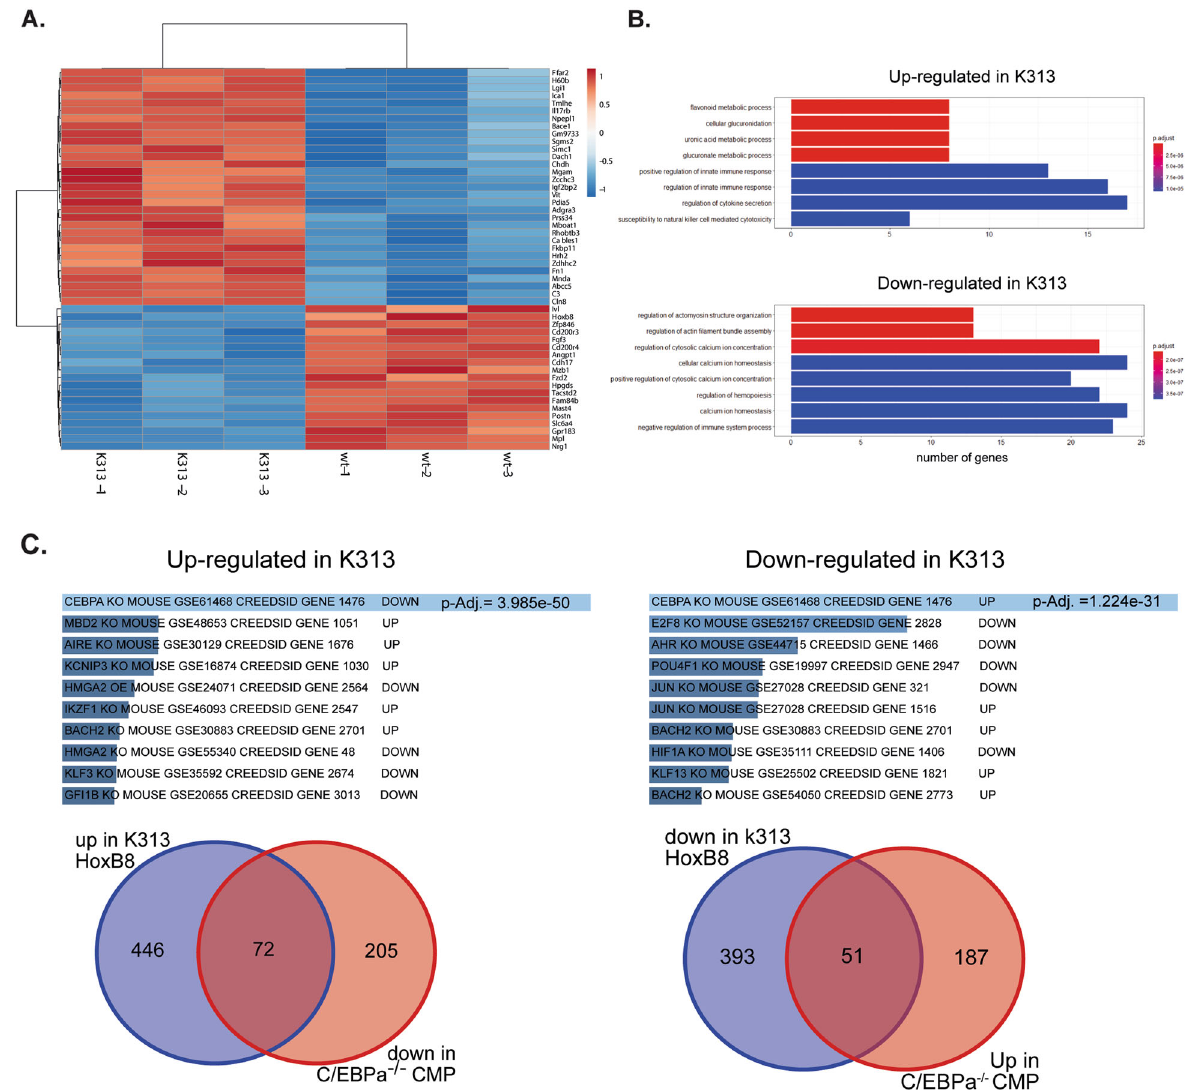
Fig. 3 Differentiating HoxB8 neutrophil progenitors show altered gene expression with C/EBP α -K313 vs. C/EBP α -wt expression. A HoxB8 progenitors were differentiated for 1 day before RNA was extracted and assayed for gene expression using an affymterix gene chip. Heatmap showing the relative expression of the 50 most signi fi cantly differentially expressed genes (DEGs) from three samples of wild type and C/EBPa- K313-expressing cells. B Bar chart showing the most signi fi cant terms in the GO:BP analyses for upregulated and downregulated genes in K313 mutant C/EBPa expressing cells. The x axis refers to the number of enriched genes in the corresponding function. C Results from ENRICHR suite analysis for transcription factor perturbations for genes upregulated or downregulated in K313 C/EBP α -expressing cells. Indicated are the top hits for transcription factor knockouts and if the genes were up- or downregulated in the respective knockouts. Also shown are Venn diagrams showing the overlap of genes in the indicated To validate our fi ndings and to test if a similar activity is present in human AML patients with C/EBP α mutations, we compared human While analysing the expression of the C/EBP α wild type and mutants, we noticed a striking difference in expression levels of wt and mutant C/EBP α proteins. Expression of C/EBP α -K313 protein was massively increased, as was C/EBP α -BRM2 hinting that this may be a feature of some C-terminal mutations (Fig. 4A). This increase in C/EBP α -K313 was independent of mRNA levels as both GFP- fl uorescence (GFP is expressed from an IRES) was similar between the cells (Fig. S9A) and quanti fi cation of C/EBP α -mRNA by qPCR showed no increase of C/ EBP α -K313 mRNA over wild type (Fig. S9B). To test if this is due to the mRNA in the K313-mutated blasts (Fig. 4D). The level of protein increased half-life of C/EBP α , we blocked protein synthesis with expression was not uniformly dependent on mRNA expression, cycloheximide and monitored C/EBP α -protein levels. Bcl-X L was co- however, suggesting that other mechanisms may also be at play. expressed to prevent cycloheximide-induced apoptosis. We found One of the C/EBP α -mutations in the AML blasts (sample #3) was a very little difference in protein stability (Fig. S9C, D) showing that the deletion of K313, not a duplication, and cells expressing this mutant higher protein levels are not due to increased stability.